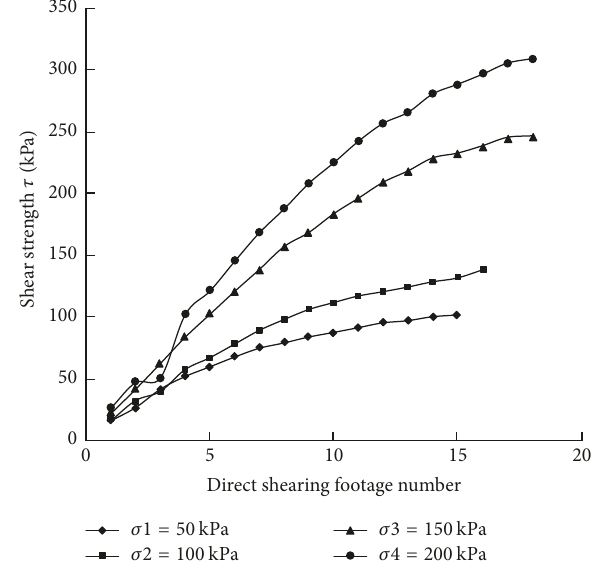
Figure 4: Direct shear experimental